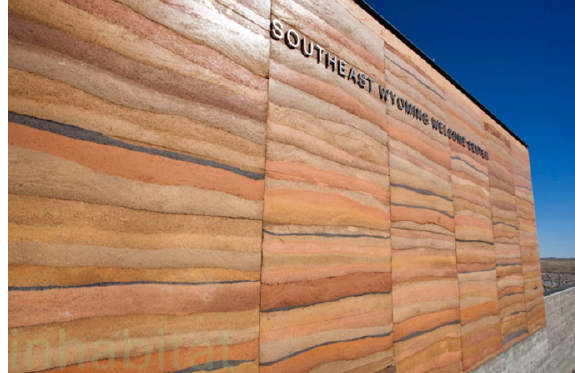
Figure 1. The tourist centre in Wyoming is built of rammed earth [11].